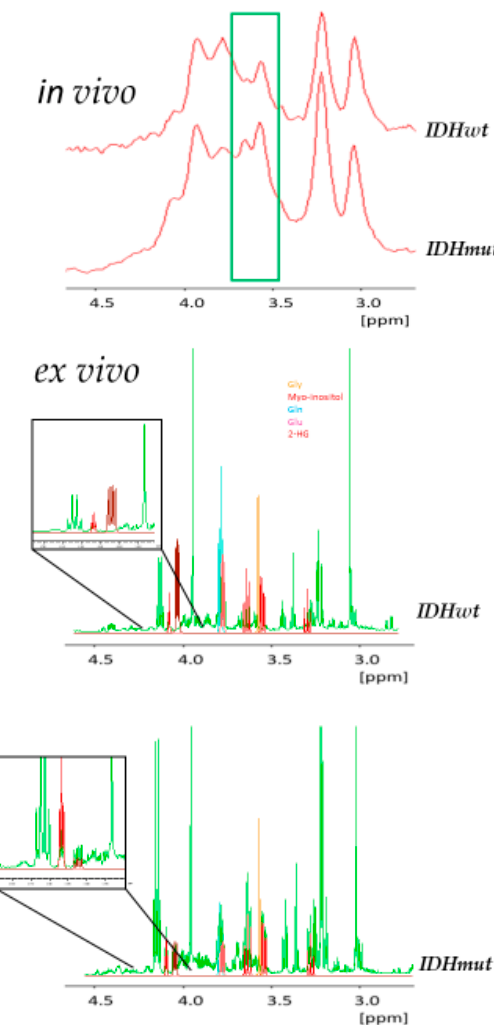
Figure 3. Predictive features. (top) Exemplary in vivo 1 H-MR spectra of IDHwt and IDHmut glioma acquired at 3T. The region of the two features used for predicting IDH mutation status is marked in green. (bottom) Exemplary ex vivo high-resolution 1D 1 H-nuclear magnetic resonance (NMR) spectra acquired at 14.1 T of methanol extractions of excised IDHwt and IDHmut glioma (green). For identification of metabolites pure compound spectra of Gly, M-ins, Gln, Glu and 2-HG are overlaid with these spectra. The two inlays show the region of the expected signal of 2-HG (dark red).